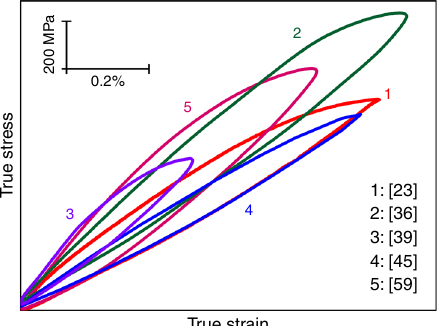
Fig. 6 Yield strength versus uniform tensile strain observed in BCC HEAs. Note that heterogeneity introduced by the addition of 2% oxygen solutes into BCC-TiZrHfNb HEA (solid red circle) markedly promotes its strength – ductility synergy (dashed line) 22 .